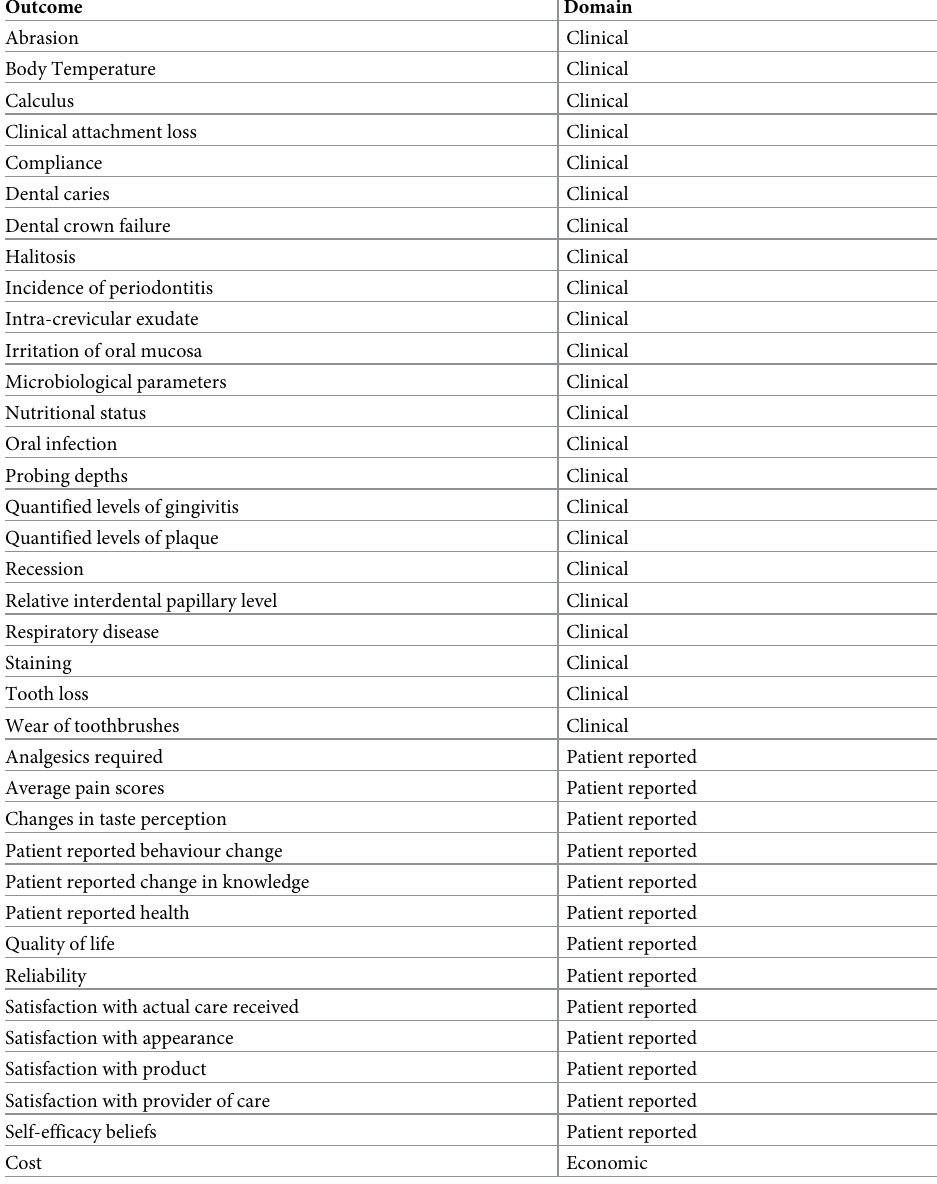
Table 1. Unique outcomes identified from Cochrane reviews, protocols and included